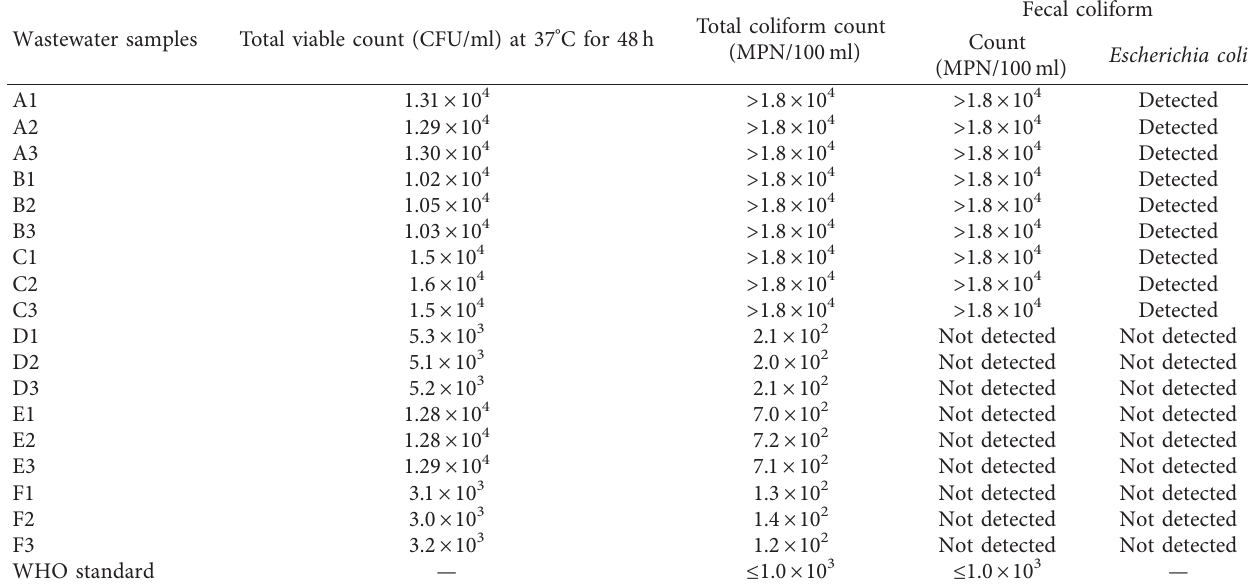
Table 4: Microbiological results of wastewater samples collected from the industrial area of